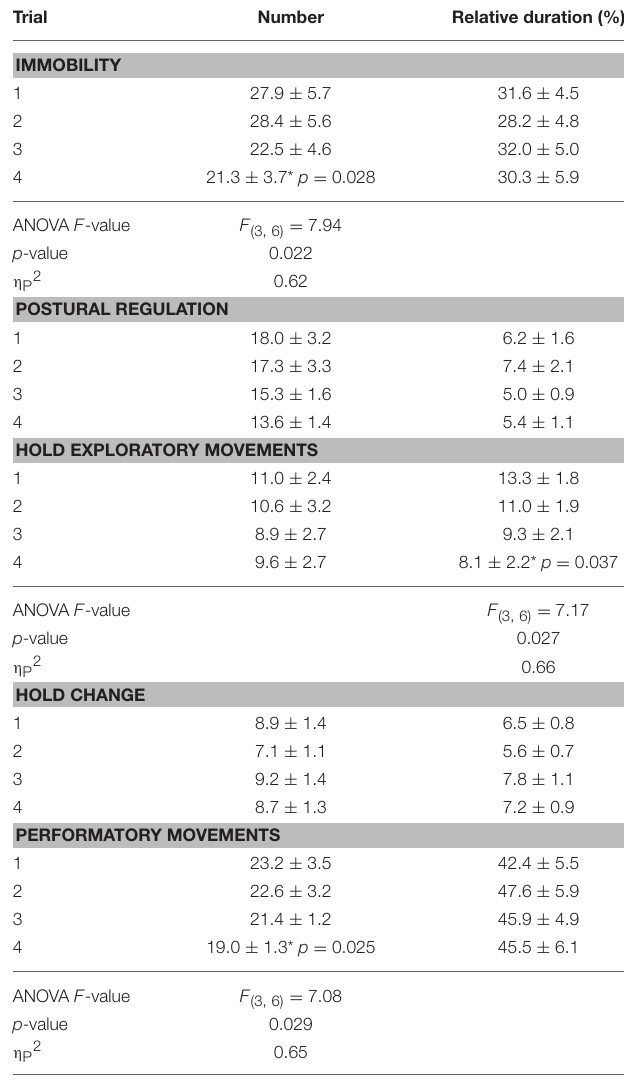
TABLE 2 | Effect of practice on number of falls, ascent duration and jerk coefficient. Trial